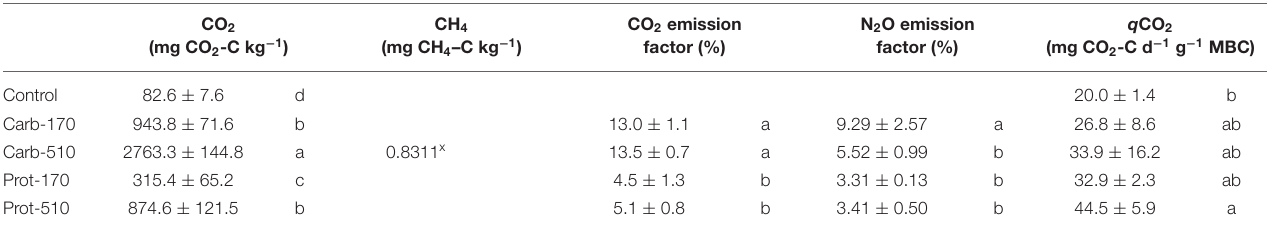
x only one replicate. Different letters in one column indicate a significant difference between